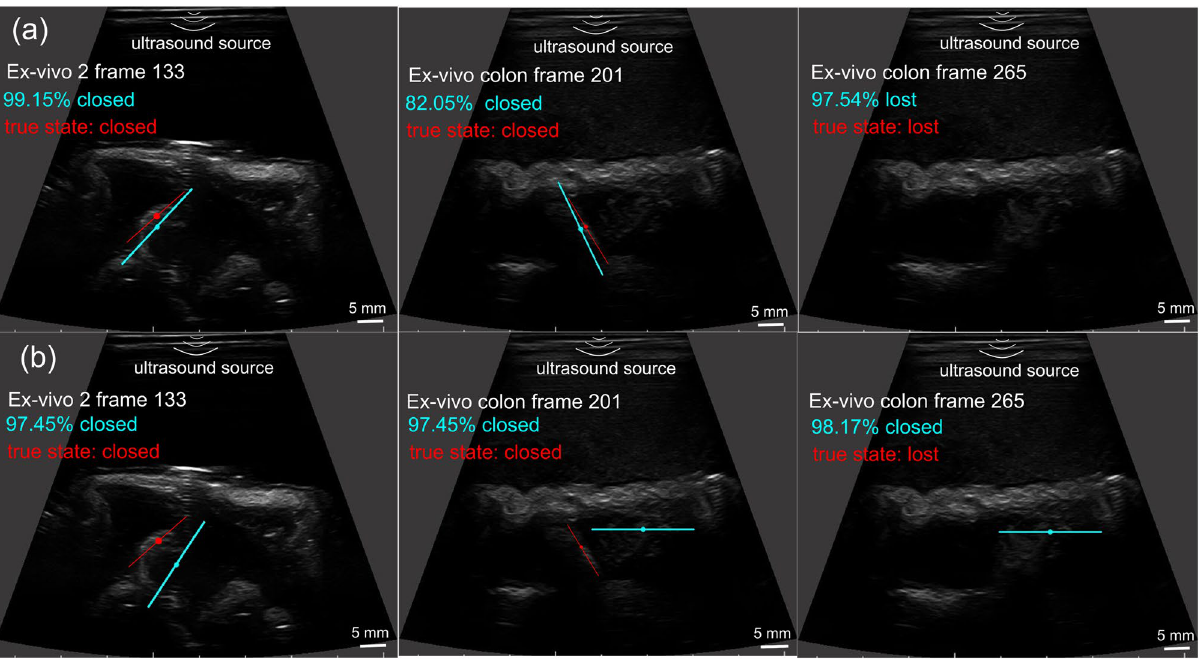
Figure 5. Comparison of the attention-based ( a ) and baseline model ( b ) for pose estimation and mechanism state detection of the capsule in three groups of frames from ex-vivo stomach and colon test